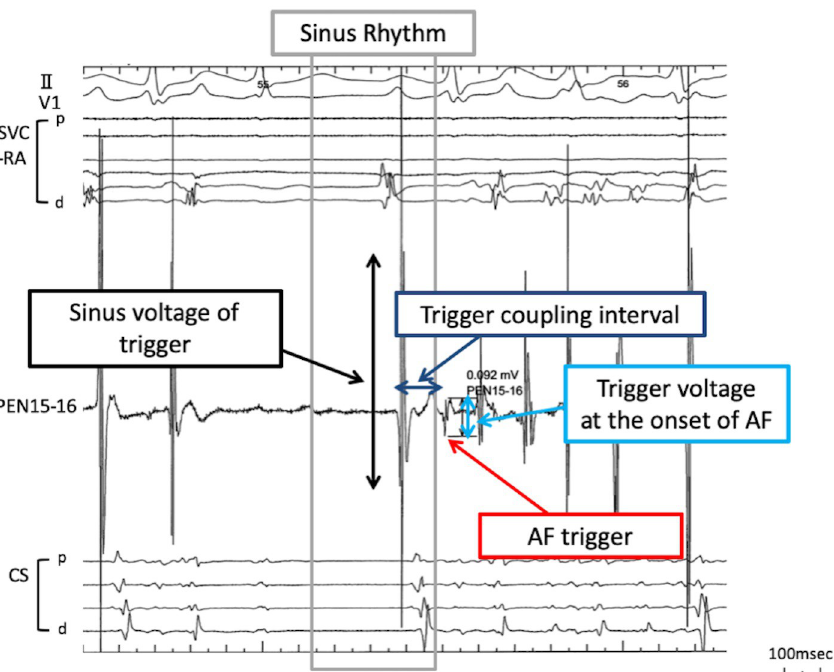
Fig 1. Illustration of the measurement of the electrophysiological characteristics at the earliest activation site. The electrogram was obtained by a PentaRay NAV catheter (Biosense Webster Diamond Bar, CA, USA) with 1-mm electrodes with 2-mm interelectrode spacing. The bipolar electrograms were filtered between 30 and 500 Hz. At the earliest activation site of the AF initiating trigger, the peak-to-peak electrogram amplitudes during sinus rhythm and at the onset of AF were measured. The trigger coupling interval was evaluated from the onset of the previous sinus beat to the onset of the trigger. CS, coronary sinus; PEN, PentaRay NAV catheter; RA, right atrium; SVC, superior vena cava.